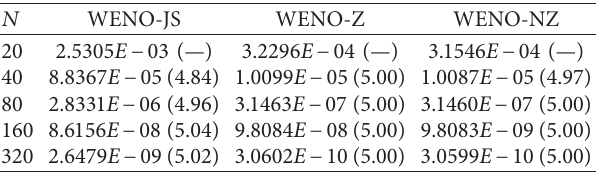
Table 3: L errors and convergence order on Case 2: 1D scalar ∞ convection equation with initial condition (60).